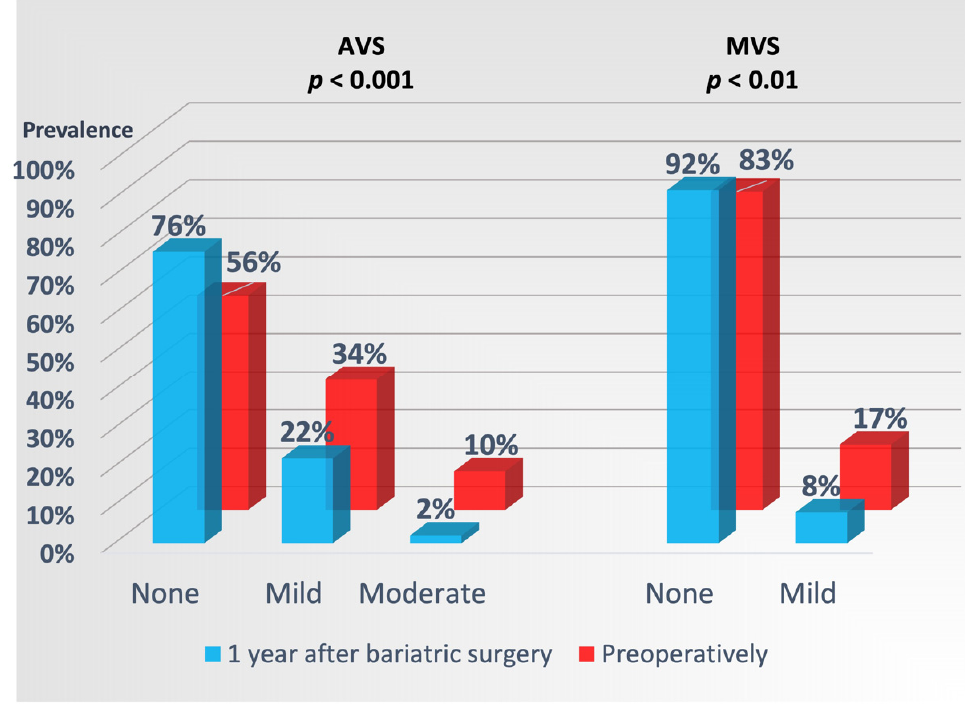
Figure 1. Prevalence of AVS and MVS preoperatively and 1 year after bariatric surgery. p values of significance for reduction in AVS and MVS after surgery, respectively.